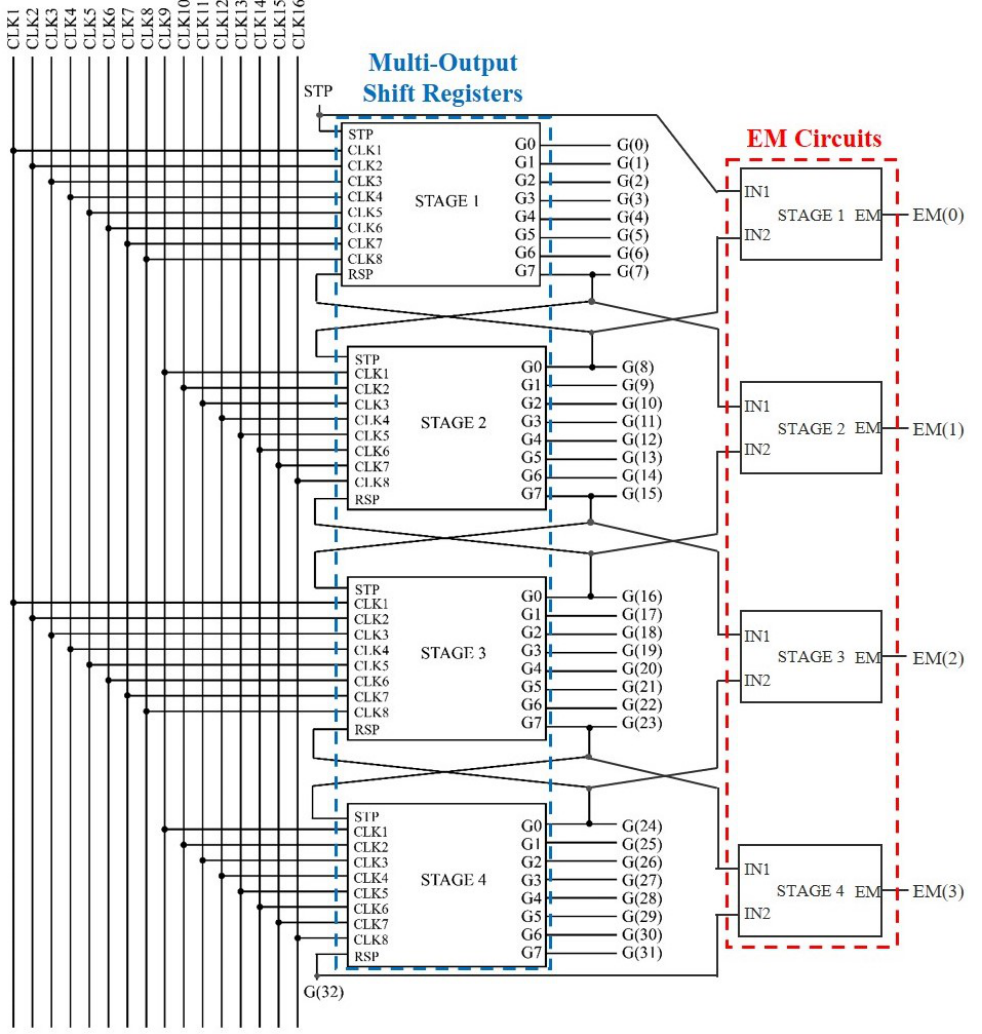
Figure 7. Overall configuration of multi-output shift registers and EM circuits in the foveation-based driving